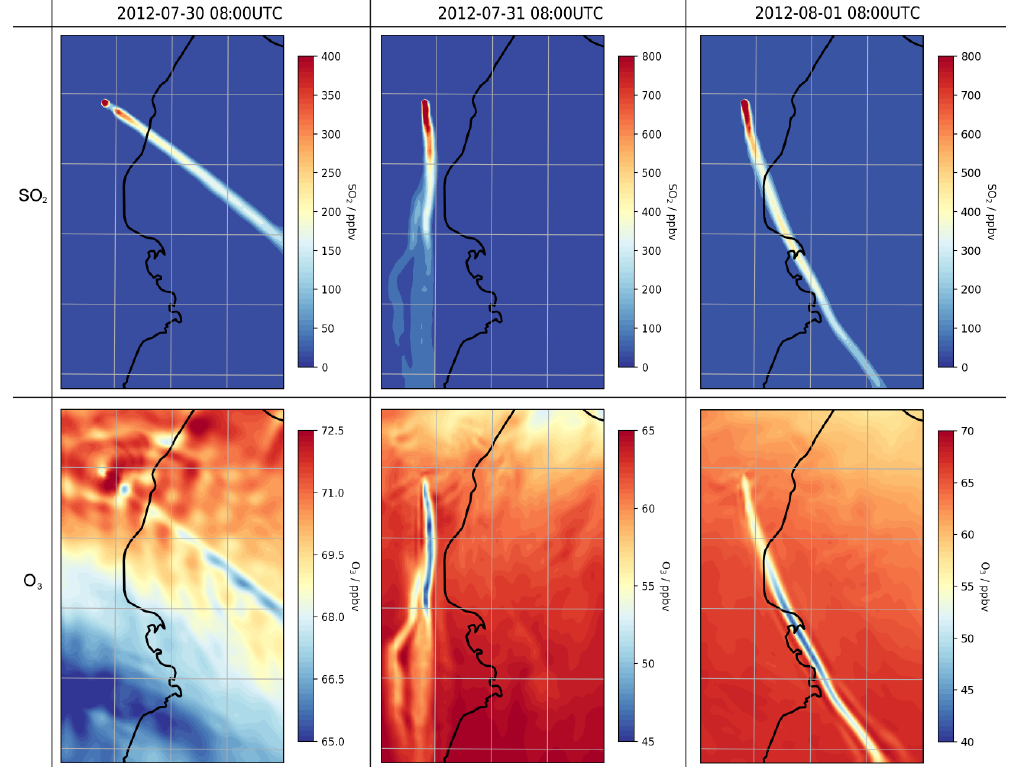
Figure 14. Modelled mixing ratios of SO 2 (first row) and O 3 (second row) at 3300ma.s.l. (volcano height) in the model at 08:00UTC on 30 July 2012 (first column), 31 July 2012 (second column), and 1 August 2012 (third column). Different colour scales are used for each